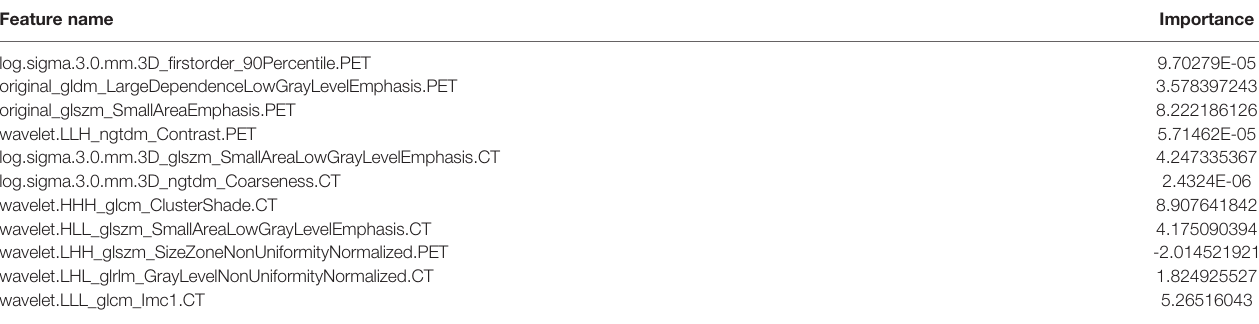
TABLE 4 | Radiomics features for calculating PET/CT radiomics scores (Rad-scores) of PFS and their